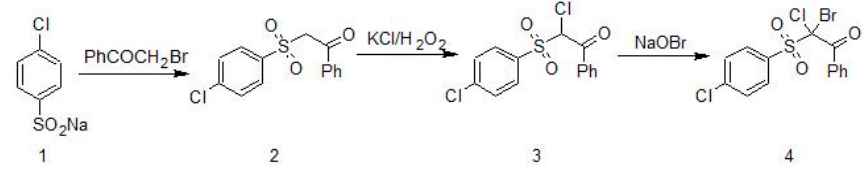
Figure 1. Synthesis of 2-bromo-2-chloro-2-(4-chlorophenylsulfonyl)-1-phenylethanone ( 4 ) [2].